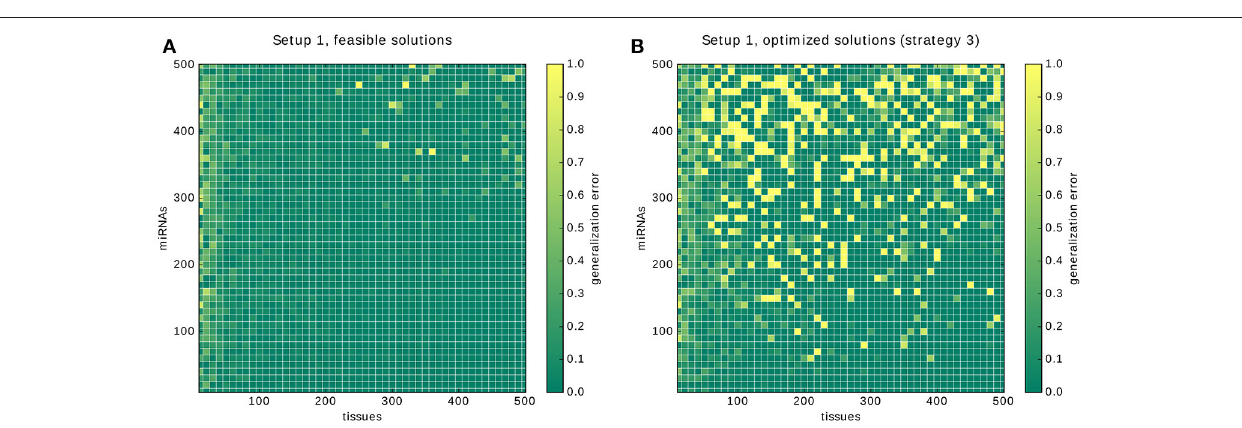
FIGURE 12 | Results of the cross-validation. The results of the cross-validation for Setup 1. (A) shows the cross-validations for finding feasible solutions. (B) shows the cross-validations for finding solutions optimized with strategy 3, that is, first gates then inputs. Note that the growing error rates are due to our conservative handling of time-outs during the validation, see main